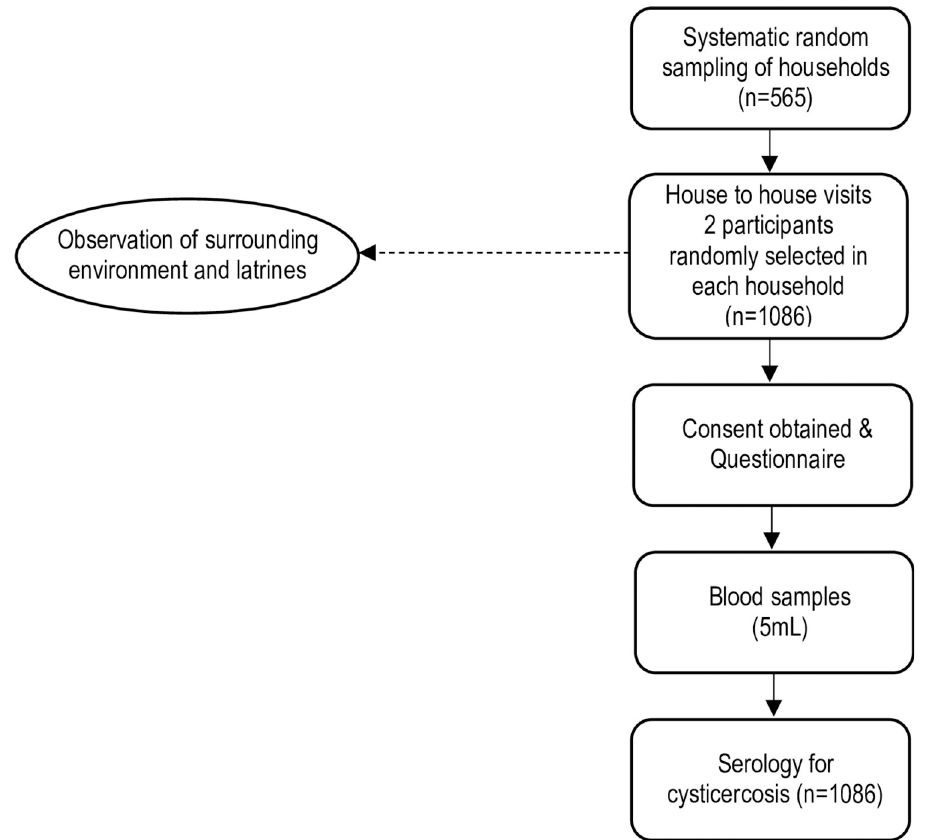
Fig 2. Data collection workflow of the study